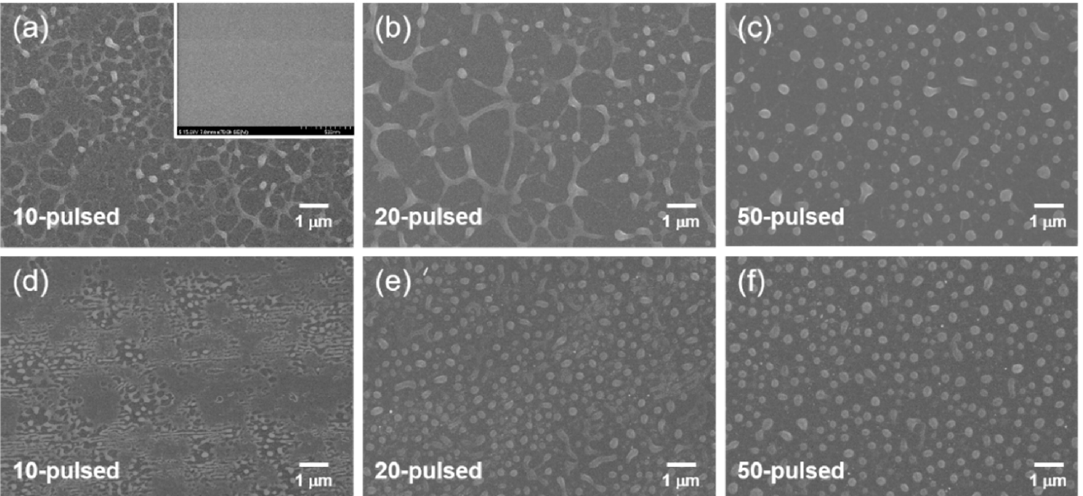
Figure 2. SEM images depicting the morphological evolution from a Co thin film to nanoparticles (NPs) through pulsed laser-induced dewetting (PLID), which follows the grooving model. Samples were prepared in vacuum ( a – c ) and air ( d – f ). Inset in ( a ) is SEM image of an as-deposited Co thin film.